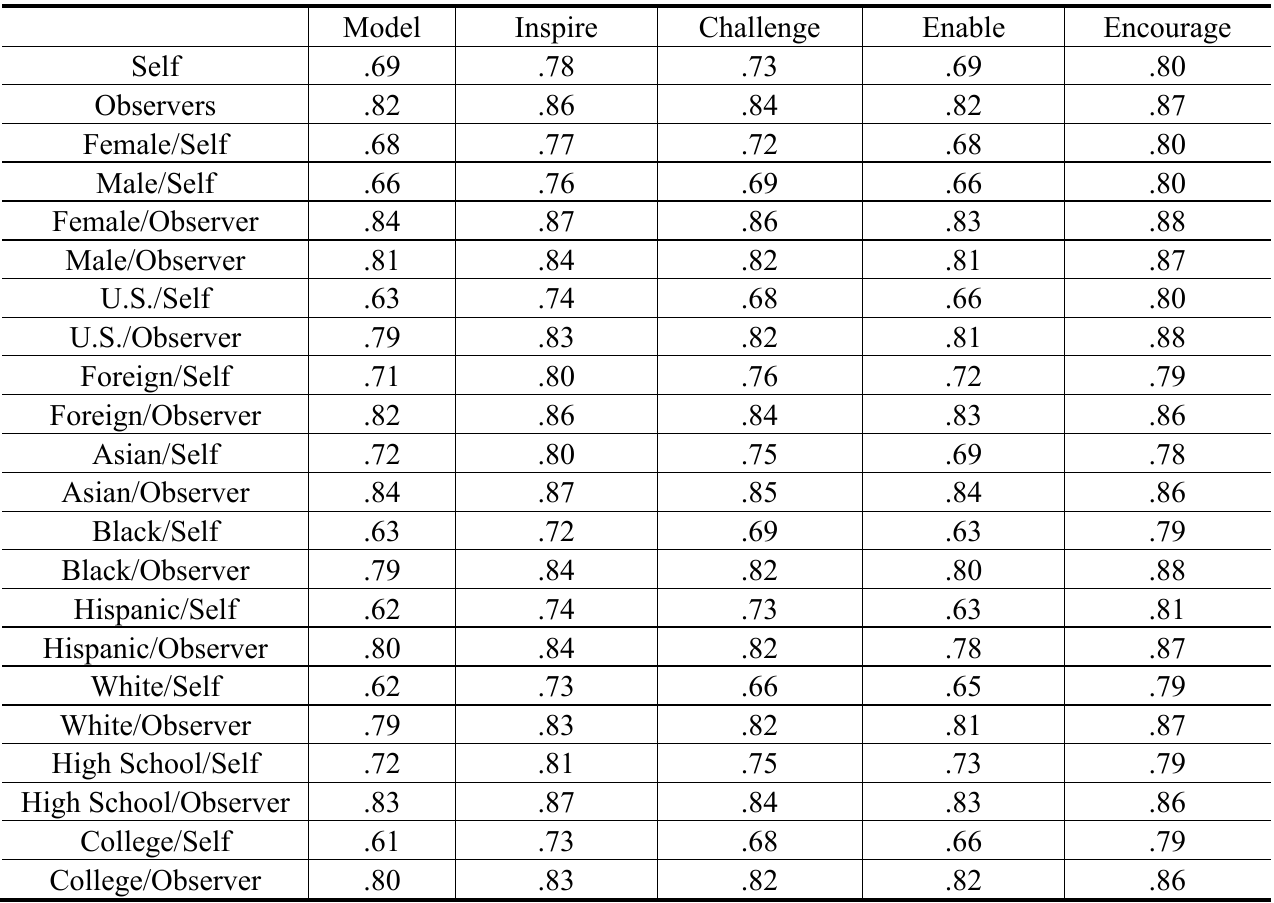
Table 1. Internal Reliability Analysis for the Student LPI (Cronbach Alpha